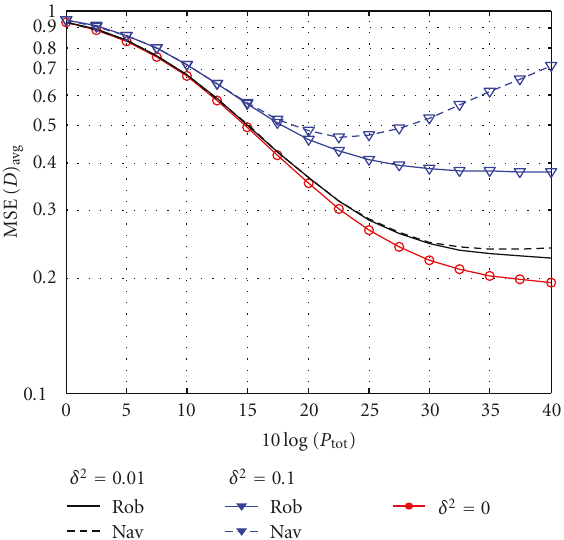
Figure 7: E ff ect of observation noise—Ex1.